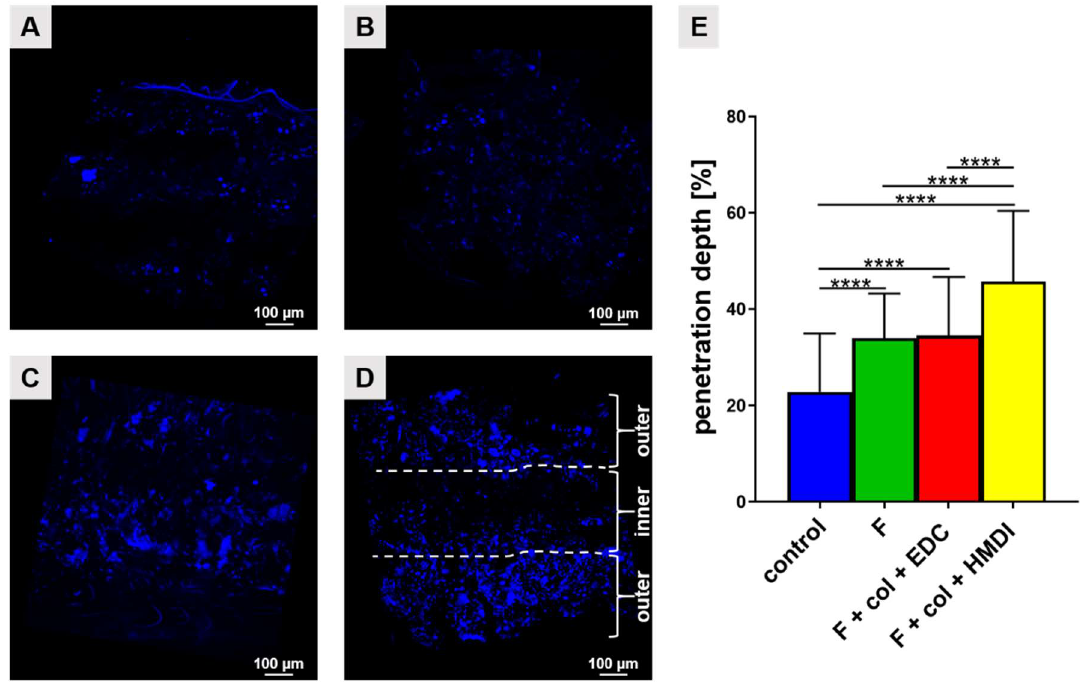
Figure 6. Penetration depth of LACL-derived fibroblasts in functionalized scaffold variants cultured dynamically with suspended cells after 7 days. 4′,6′-diamidino-2-phenylindol (DAPI, blue) staining of cell nuclei in non-functionalized scaffold ( A ), the fluorinated scaffold ( B ), fluorinated + collagen + EDC scaffold ( C ) and fluorinated + collagen + HMDI scaffold ( D ). Representative images of the vertical cross section of scaffolds of three independent experiments using cells from three different donors. Cell nuclei are shown in blue. The three layers of the scaffold were marked with dashed white lines in D . Scale bars of 100 µm. The mean of the migration distance of cells into the scaffold is shown ( E ). One sample t test, two-tailed (comparison of different concentrations with control), one-way ANOVA (post hoc Tukey Test) for comparison between the groups. p values: **** < 0.0001. Col, collagen foam; F, fluorinated; EDC, ethylcarbodiimide cross-linked; HMDI, hexamethylene diisocyanate